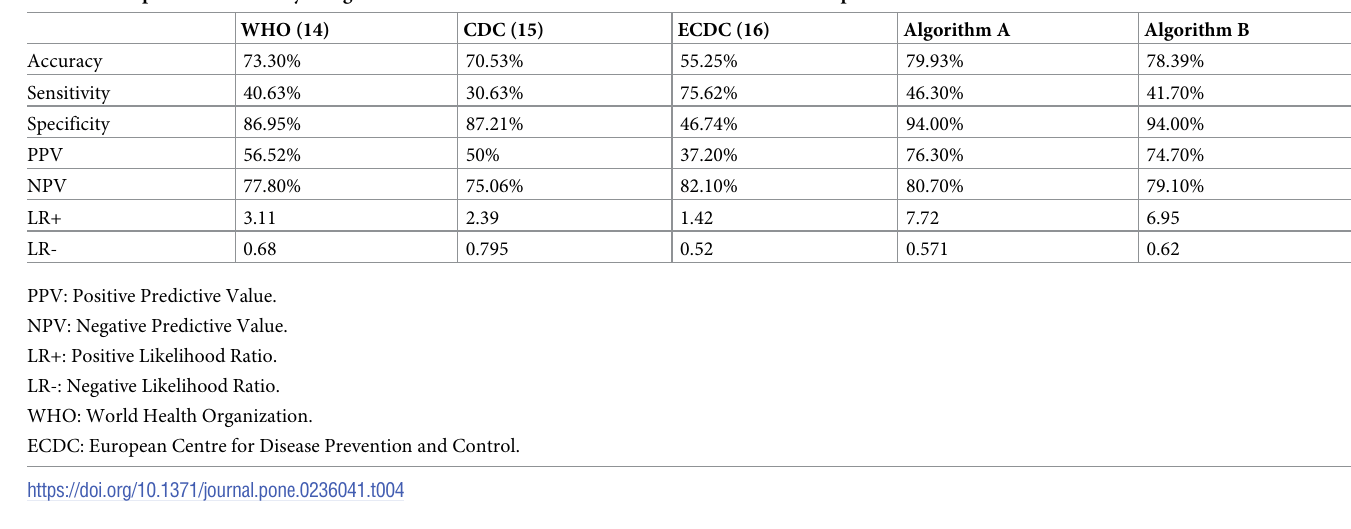
Table 4. Comparison of accuracy of algorithms with some clinical surveillance case definitions for